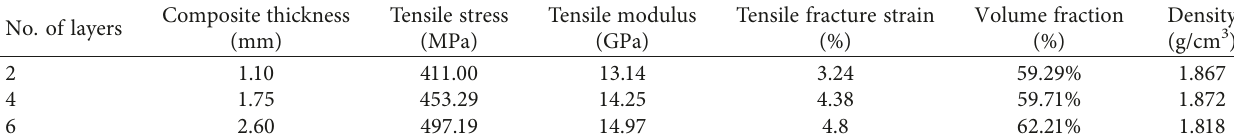
Table 1: Mechanical properties of basalt fiber composites.